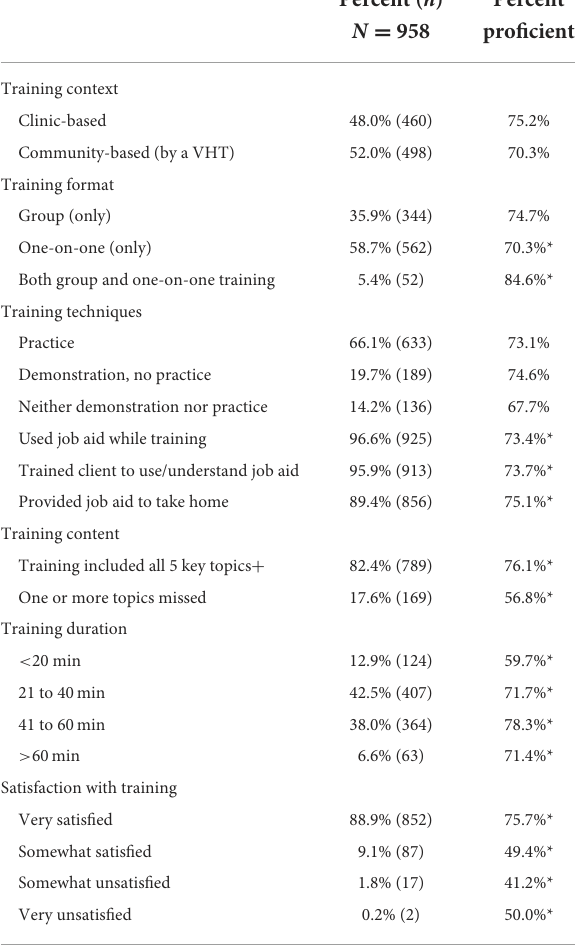
TABLE 2 Training experiences and association with injection proficiency, SI